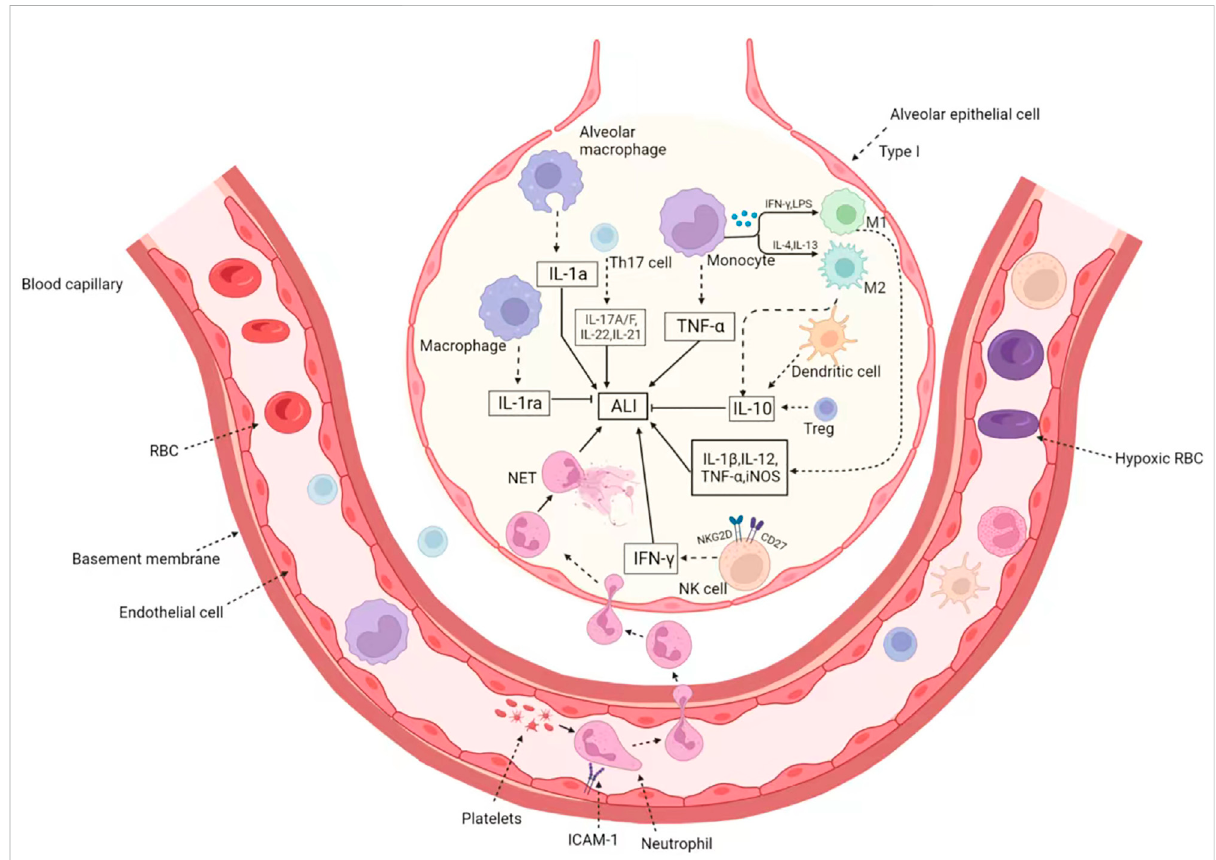
FIGURE 1 The immune cells in Acute lung injury/acute respiratory distress syndrome. When ALI occurs, various immune cells are recruited through the blood vessels to the in fl ammatory region and enter the alveoli through the swollen outer walls of the blood vessels. On the one hand, neutrophils recruit platelets to form microthrombus, endothelial cells expressed ICAM-1 and increased platelet adhesion. On the other hand, they form NET through capillaries to enlarge in fl ammatory lesions. The activated macrophages are divided into M1 type and M2 type. M1-type macrophages induced byIFN- γ andLPSsecretepro-in fl ammatoryfactors suchas IL-1 β ,IL-12,TNF- α , andiNOS.WhileM1macrophages induced byIL-4andIL-13 have the opposite function, which product IL-10 and relief ALI. In addition, eosinophils, NK cells, dendritic cell and Treg cells were also recruited to play different roles. Treg and dendritic cells secrete IL-10 to inhibit in fl ammatory response, and activated NK cells overexpress NKG2D and CD27 receptors, release IFN- γ , and promote the occurrence of